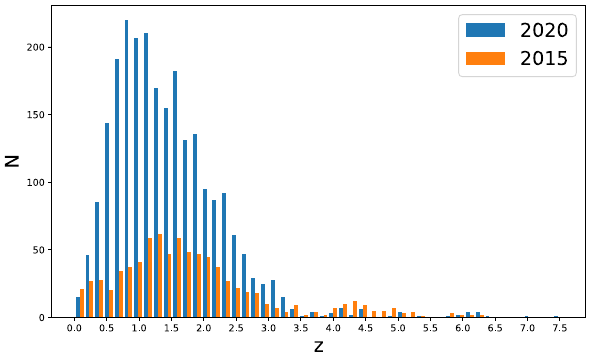
Fig. 1 The redshift distributions of the 2015 and 2020 quasar compi- lations. The orange histogram denotes the 2015 quasar compilation and the blue histogram denotes the 2020 quasar